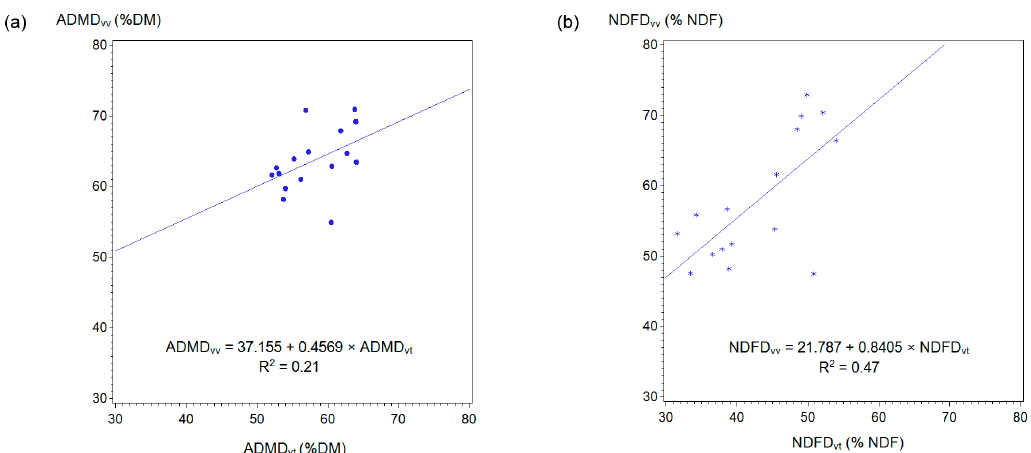
Figure 2. Relationship between 60-h in vitro digestibility using the Daisy II Incubator and in vivo digestibility. ( a ) Dry matter digestibility. ( b ) Neutral detergent fiber digestibility. ADMDvv, apparent in vivo dry matter digestibility; ADMD vt , apparent in vitro dry matter digestibility; NDFD vv , in vivo neutral detergent fiber digestibility; NDFD vt , in vitro neutral detergent fiber digestibility. DM, dry matter; NDF, neutral detergent fiber.